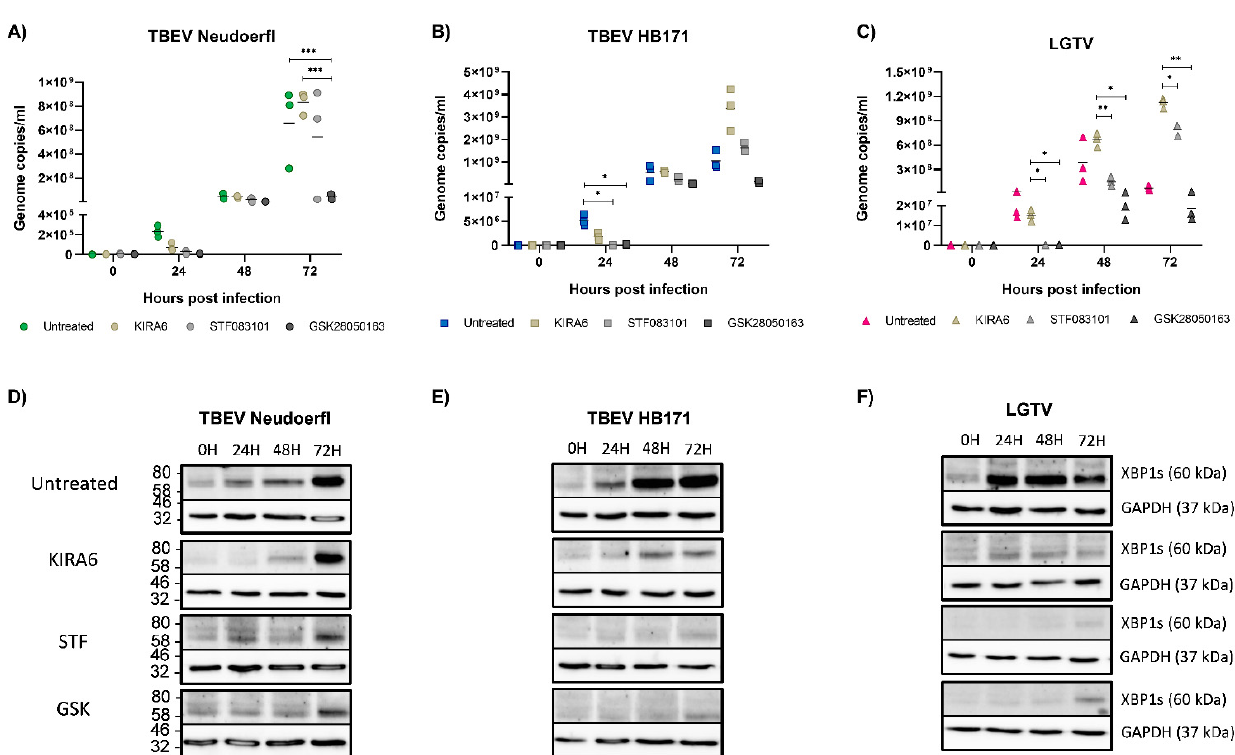
Figure 6. Infection experiments in the intestinal cell line Caco-2 were performed as described in Figure 4. Infections of untreated cells with Neudoerfl are shown in green ( A ), HB171 in blue ( B ) and LGTV in pink ( C ). Infections of cells pretreated with KIRA are shown in light brown, STF in light grey and GSK in dark grey, respectively. All infections were performed in triplicates and repeated three times. Statistical analyses were performed by 2-way ANOVA with Tukey’s multiple comparison test, * p < 0.033, ** p < 0.002, *** p < 0.001. Cell lysates were analyzed by Western blot for XBP1 expression after infection with Neudoerfl ( D ), HB171 ( E ) or LGTV ( F ). GAPDH expression was analyzed as a housekeeping control. A representative blot is shown. kDa, kilodalton.